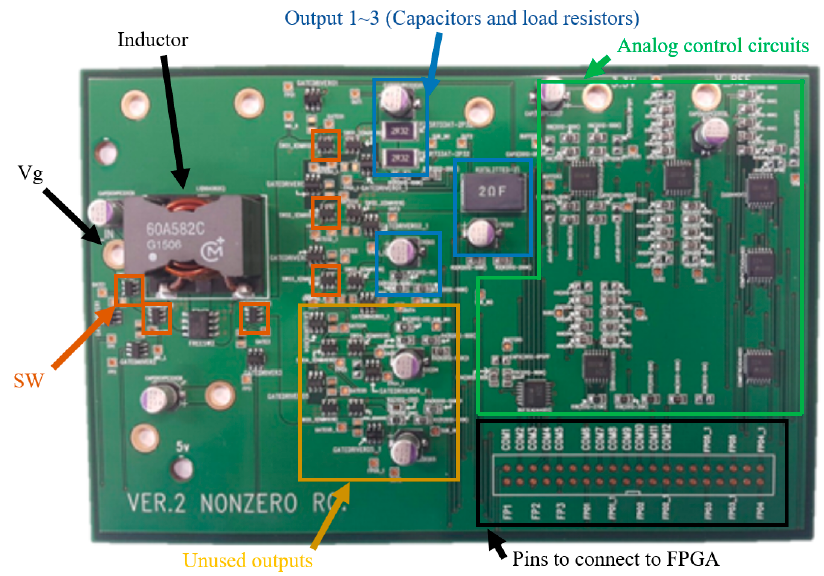
Figure 11. Fabricated SIMO auto-buck-boost DC–DC converter. It is implemented with discrete components on PCB board. In the PCB, there are 5 outputs, but only 3 outputs were used in the experiments. Table 2. Specifications and component values of the proposed